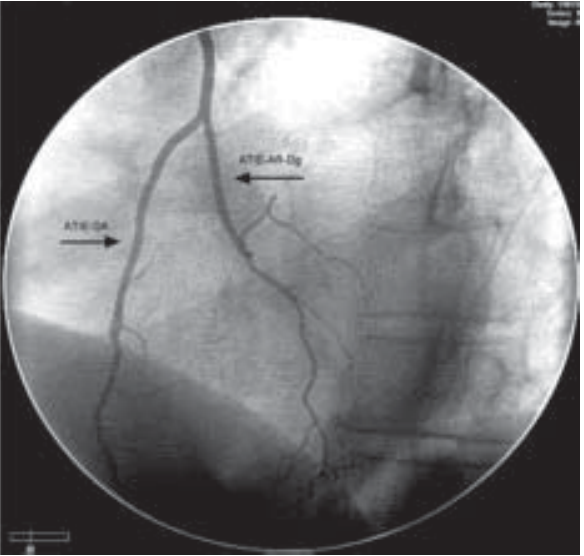
Fig 6 - Anastomoses in “Y” shape Left internal thoracic artery – Radial artery